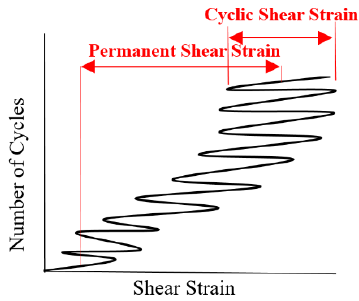
Figure 9. Cyclic shear strain and permanent shear strain in a simple shear test (Reprinted from [37]).